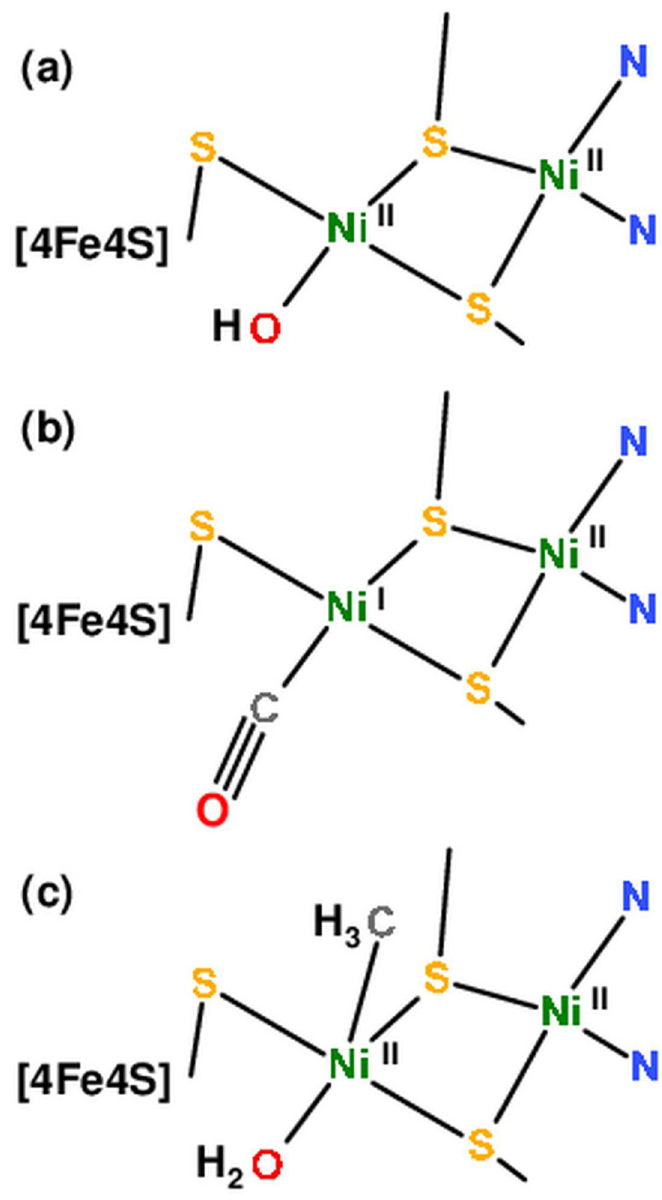
Fig 5. Structural models for [NiNi] sites in ACS Ch . Overall geometriescorrespondto crystal structure 1RU3 [15], ligandassignmentsagree with our XAS analysis. (a) Oxidized A-cluster with two square-planar Ni (II) ions. Ni(I) p presumably is formed in reducedenzyme, leadingto protonationof the equatorialOH - to a (neutral)water ligand. (b and c) Reducedenzyme with Ni p -bound(equatorial) carbonmonoxideor with (apical)methyl and (equatorial) water ligands. Tentative assignmentof the proximalsite as Ni(II) in the methyl/ water-bound state of reducedenzyme may imply reductionof the [4Fe4S] cluster by chargetransfer from the [NiNi] site [30]. We note that oxidationstate assignmentsare formal. Further nickel site geometry distortion (i.e. towards more tetrahedralligandarrangements) in reducedproteins may not be excluded,but is not uniquelyimpliedby our XAS